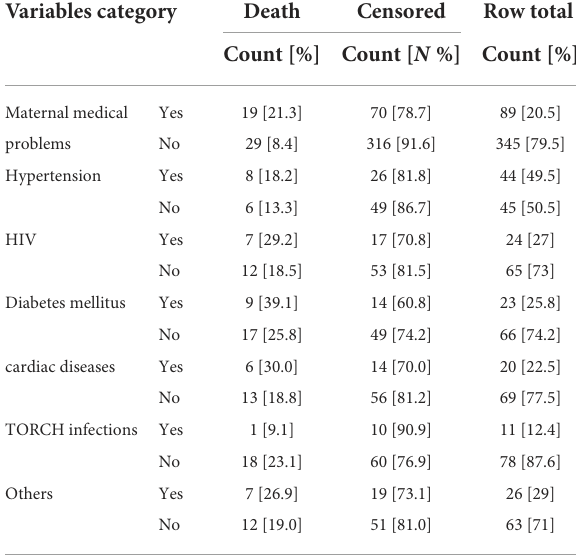
TABLE 3 Maternal Gynecologic, and obstetric conditions at NICU, TASH, Addis Ababa, Ethiopia, from 1 January 2015 – 30 December 2021.